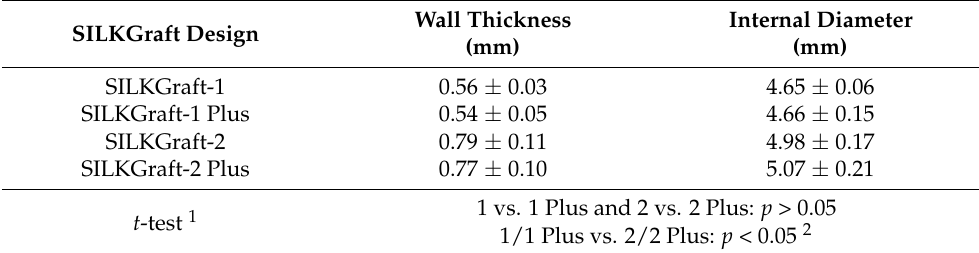
Table 2. Geometrical and morphological